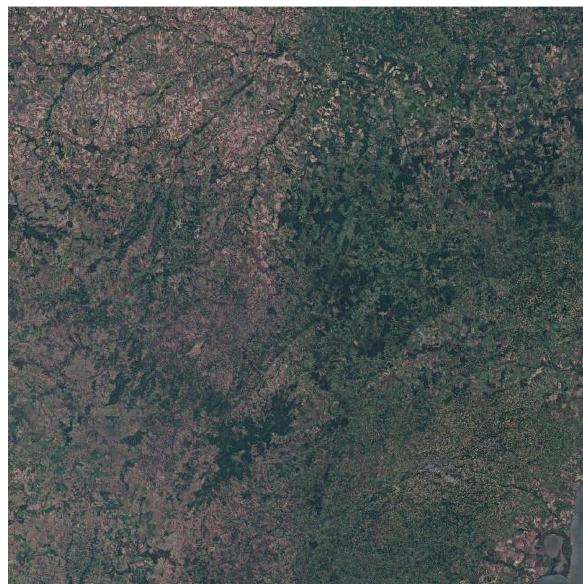
Figure 15: Hard seam lines eliminated between tiles post